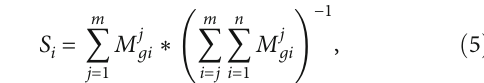
Table 12: Value of fuzzy vector weight of criteria.